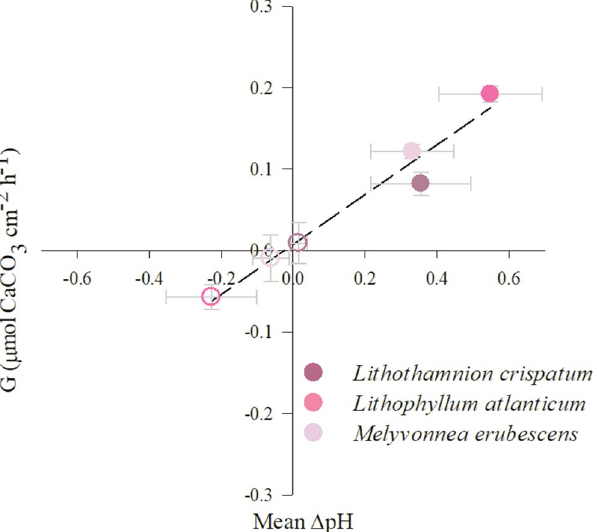
Figure 5. Linear relationship between light and dark ΔpH of the algal thallus surface compared to bulk seawater (mean between protuberance tip and base) and rhodolith light (filled circles) and dark (empty circles) calcification rates (R 2 = 0.96, p = 0.0006).